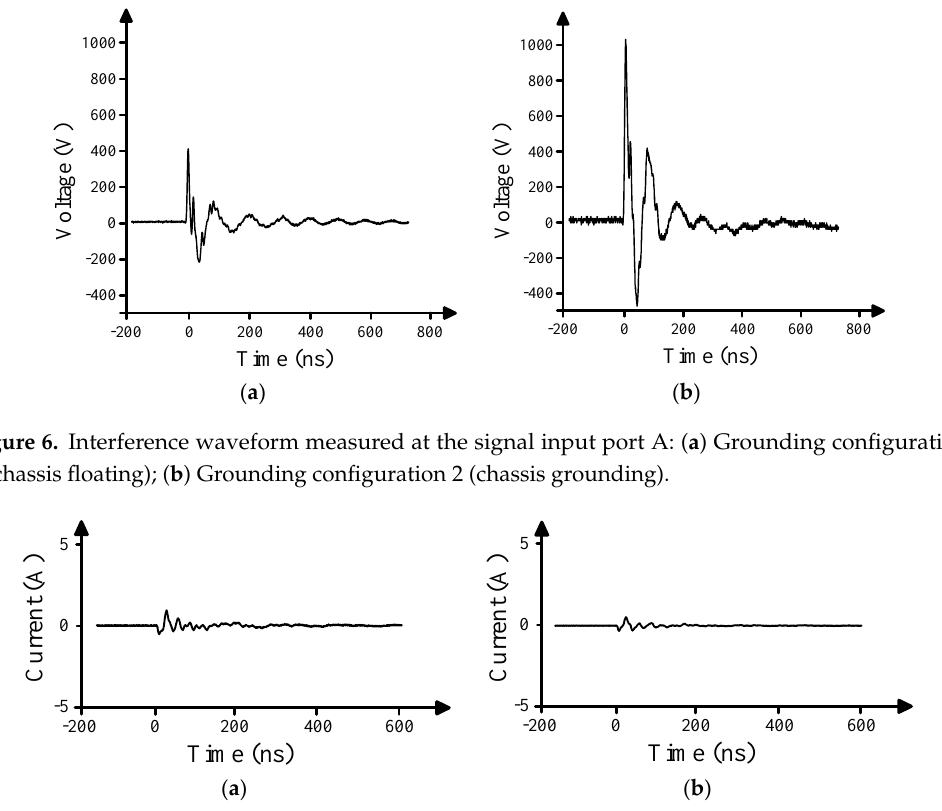
Figure 7. The interference current waveform measured at the N line: ( a ) Grounding configuration 1 (chassis floating). ( b ) Grounding configuration 2 (chassis grounding).